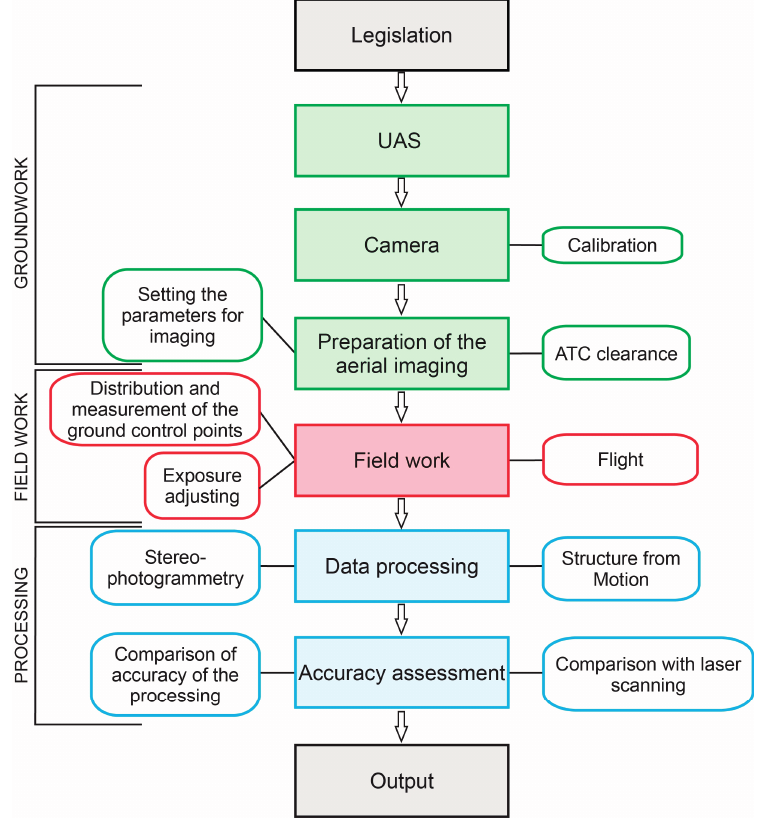
Figure 2. Workflow diagram of the aerial imaging